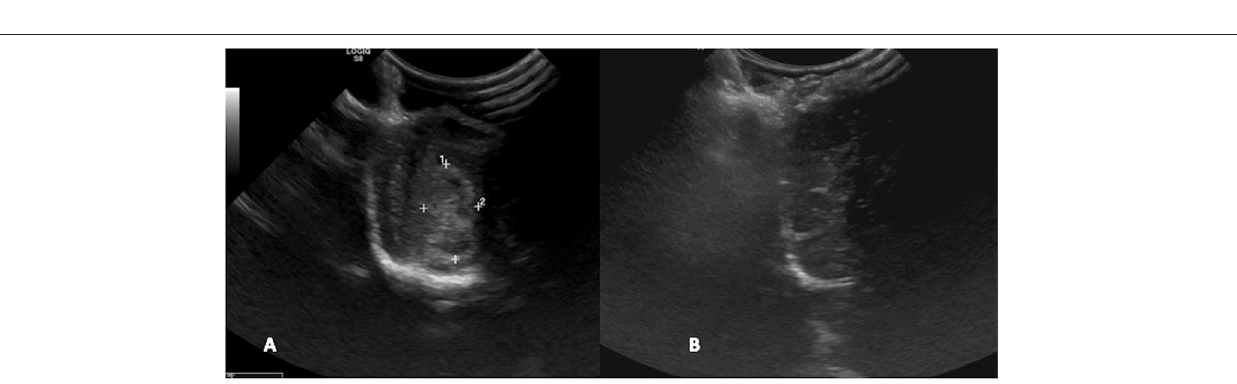
FIGURE 10 | Case 29. (A) Intraoperative ultrasound appearance of frontal meningioma before removal and (B) following gross tumor resection.